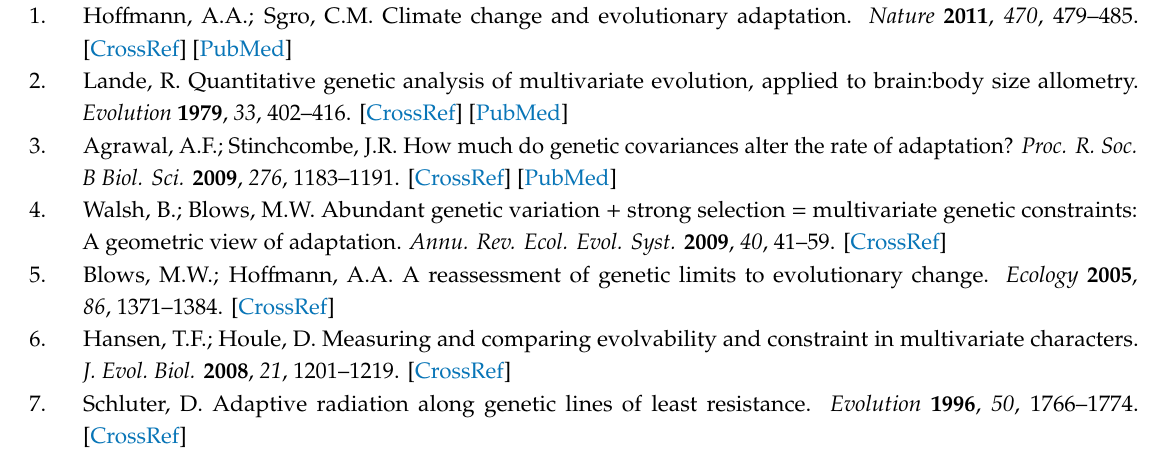
Table S6: Mean values of unconditional evolvability, conditional evolvability, autonomy and flexibility based on the estimated G -matrix common to all populations. Table S7: Amount of divergence from the inferred ancestral states, unconditional and conditional evolvabilities along the direction of divergence ( z ), and angle between z and g max , for the studied populations. Table S8: Principal component analysis of the G and D matrices estimated across all the studied populations. Table S9: Comparison of the G and D matrices estimated across all the studied populations in measures of matrix size, shape, and